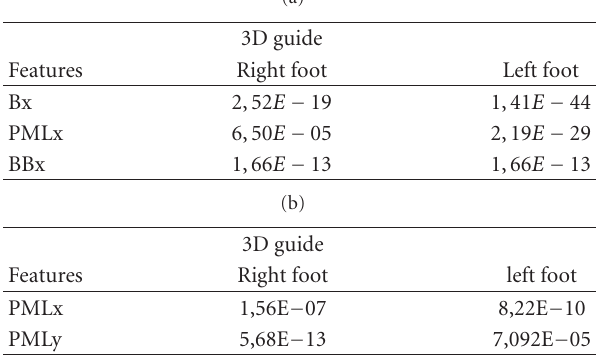
Table 5: ANOVA test analysis sample of the most repeatable features. (a) Male subjects, (b) female subjects.